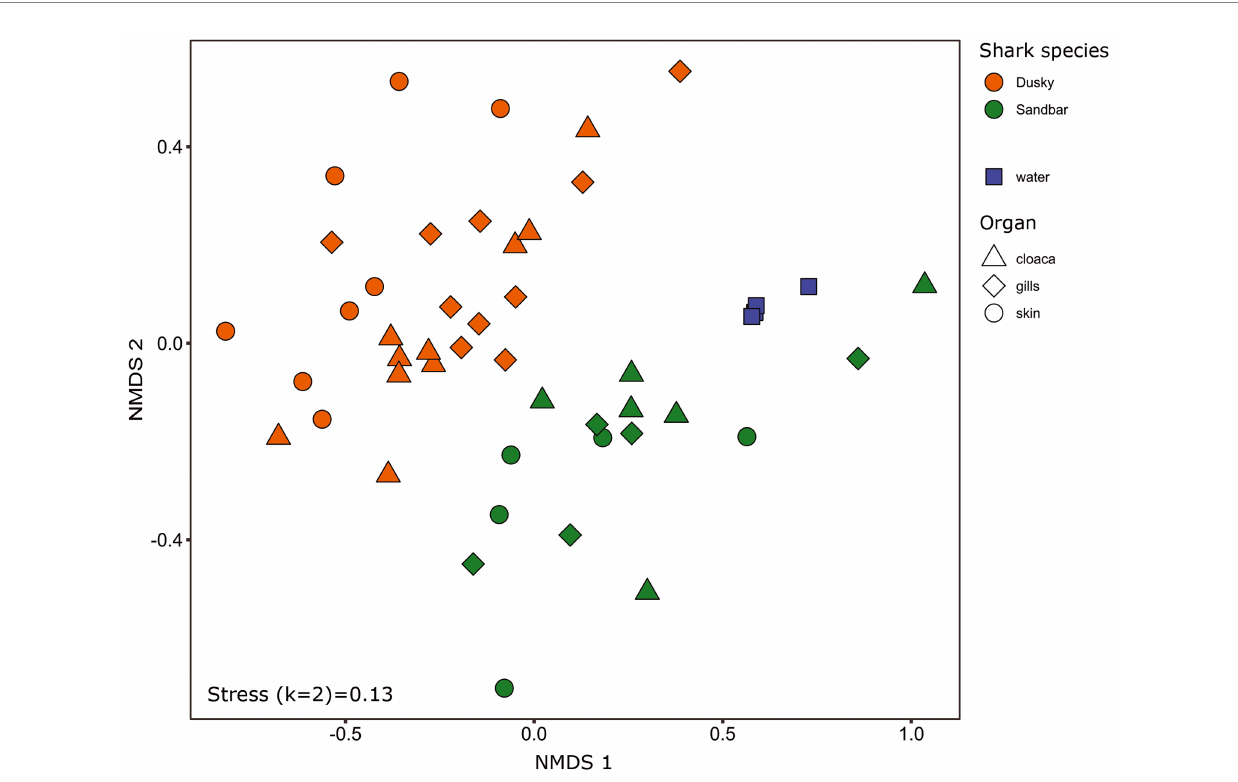
FIGURE 1 Bacterial profiles of shark species, organs and the surrounding seawater. Non-metric multidimensional scaling analysis was calculated based on Bray– Curtis dissimilarities among samples. Colors represent shark species, and shapes represent different